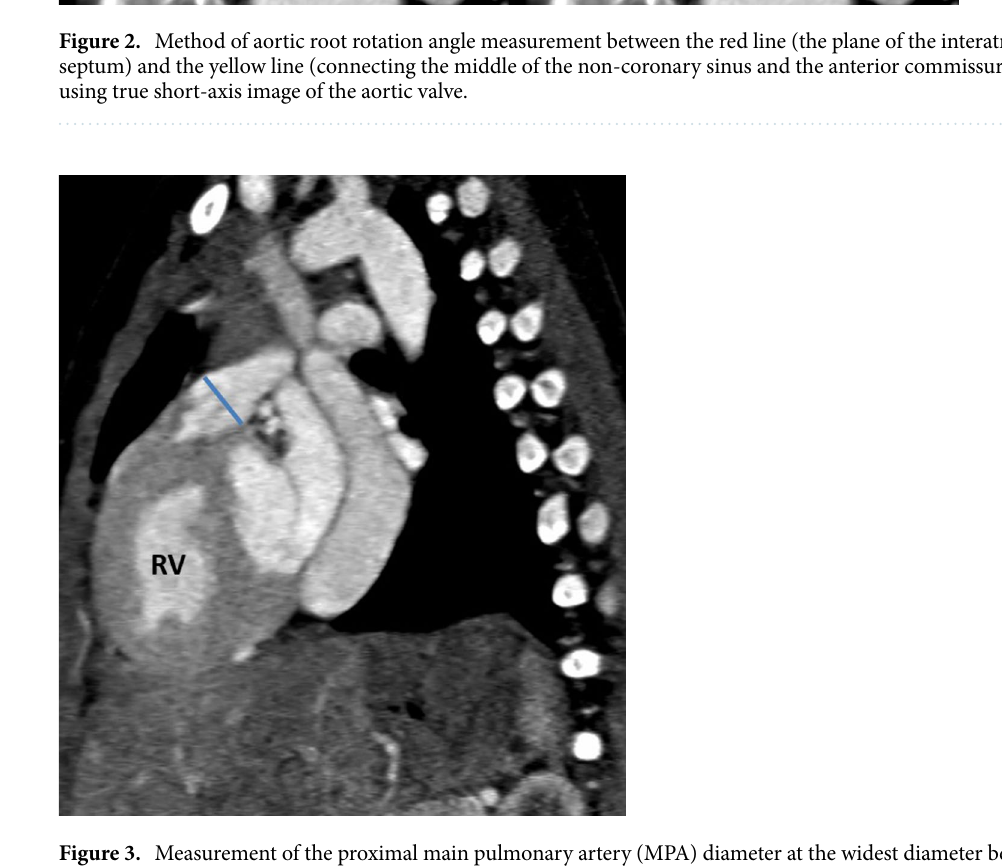
Figure 3. Measurement of the proximal main pulmonary artery (MPA) diameter at the widest diameter before bifurcation, the diameter of MPA is indexed to the